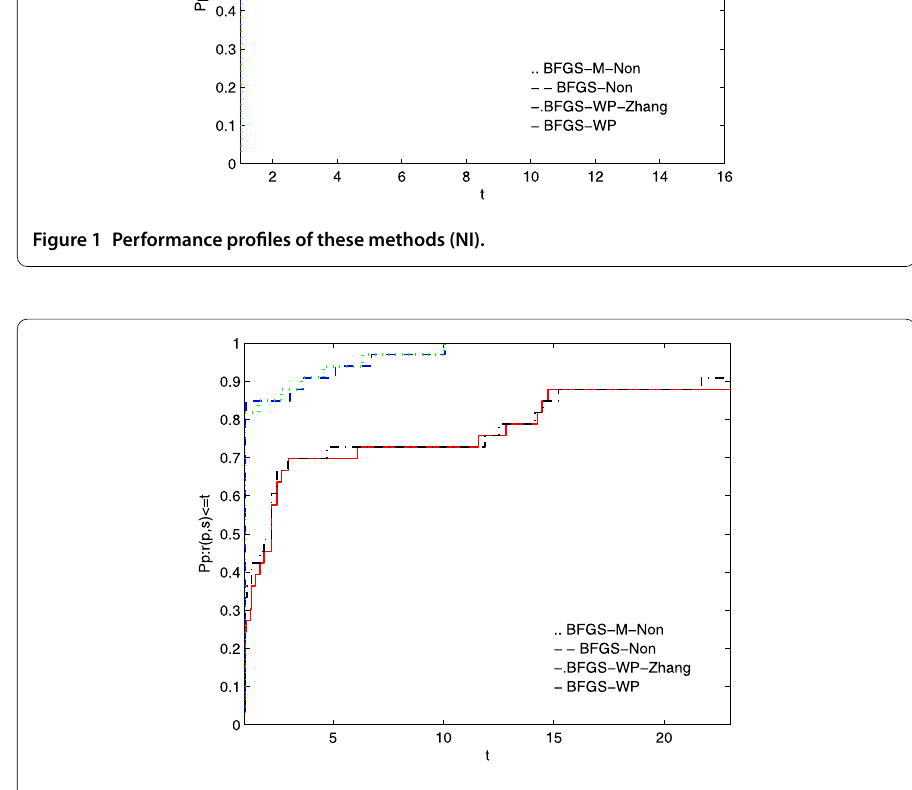
Figure 2 Performance profiles of these methods